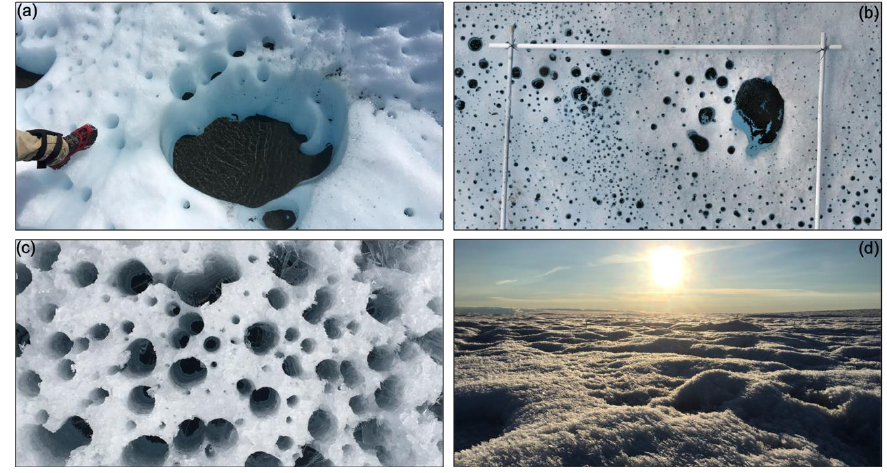
Figure 11. Images of cryoconite hole-studded ice surface in the western Greenland Ice Sheet ablation zone, collected at ( a ) ~850 m a.s.l.; ( b ) ~950 m a.s.l.; and ( c ) ~1200 m a.s.l. along an elevation transect outside Kangerlussuaq (Søndre Strømfjord). At the low and mid-elevation sites, the ice surface is glazed and smooth, and the water table within the cryoconite holes is nearly coincident with the ice surface. At the high-elevation site ( c ), the surface is rougher, and evidence of nocturnal refreezing is visible. ( d ) Same location as ( c ), showing the rough, weathered ice surface at low sun angle, reprinted from Cooper et al. [85]. Quadrat shown in ( b ) is 3 m wide. Cryoconite holes in ( c ) are on the order of 1–5 cm wide. Seasonal weathering of the ice surface, including cryoconite hole deepening and removal, exerts a primary control on ice roughness and grain morphology but its e ff ect on bare ice albedo has received little direct study